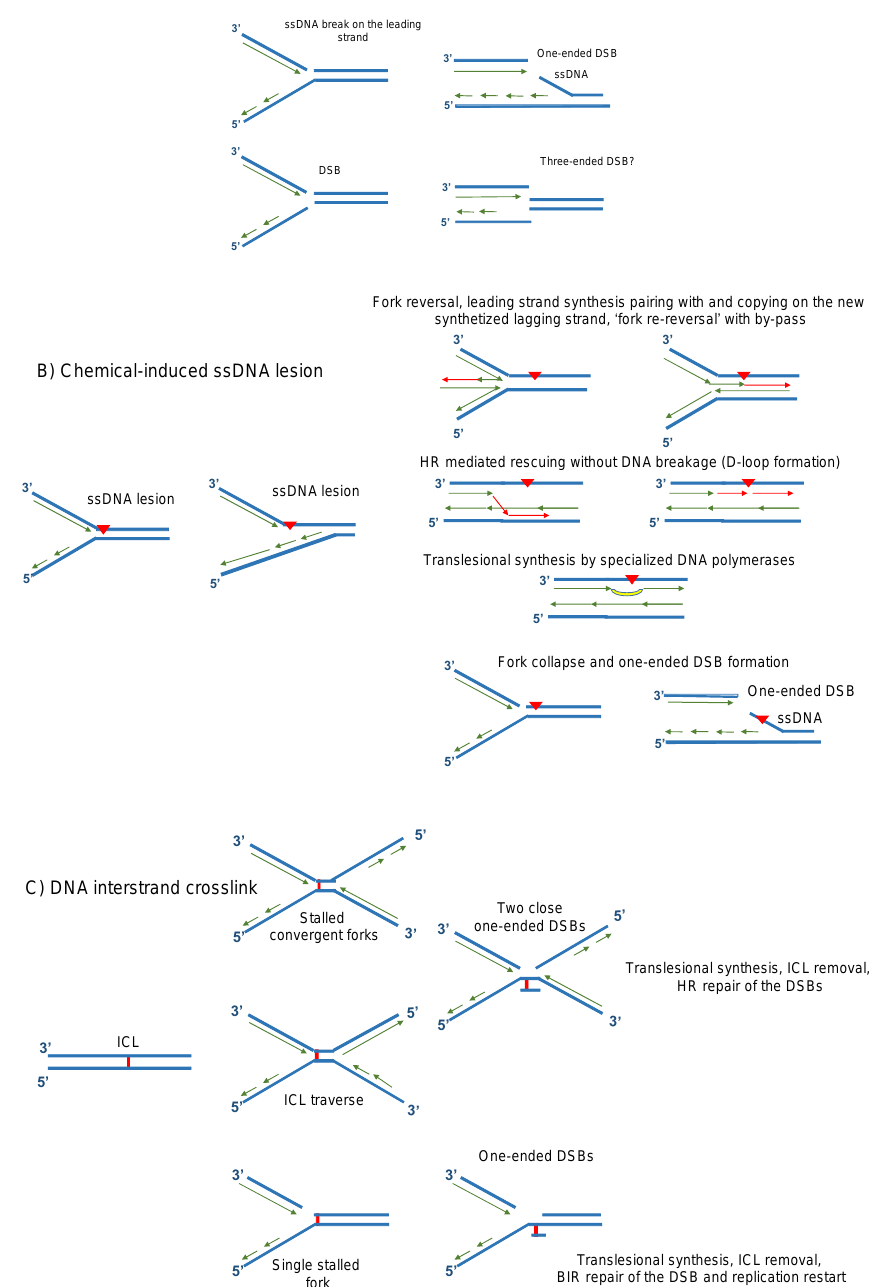
Figure 3. Possible outcomes of replication forks meeting a DNA lesion. ( A ) The replication fork might encounter an unrepaired ssDNA break on the leading strand or a DSB which will create a one-ended or a three-ended DSB. ( B ) The fork might also encounter chemically modified bases affecting one strand. Halted replication in this case can be rescued using several mechanisms including fork reversal, fork re-reversal with bypass, HR-mediated D-loop formation, and translesional synthesis to prevent fork collapse and associated DNA breakage. ( C ) An ICL, linking the two opposite strands of the same DNA molecule, can also block fork progression. Two convergent forks or a single fork can be affected by the recently described ICL traverse mechanism, that allows replication progression, leaving the lesion and a short unreplicated sequence behind the fork. Several repair proteins are activated to remove the ICL, repair the associated DNA repair-induced DSB, and rescue replication through HR-mediated